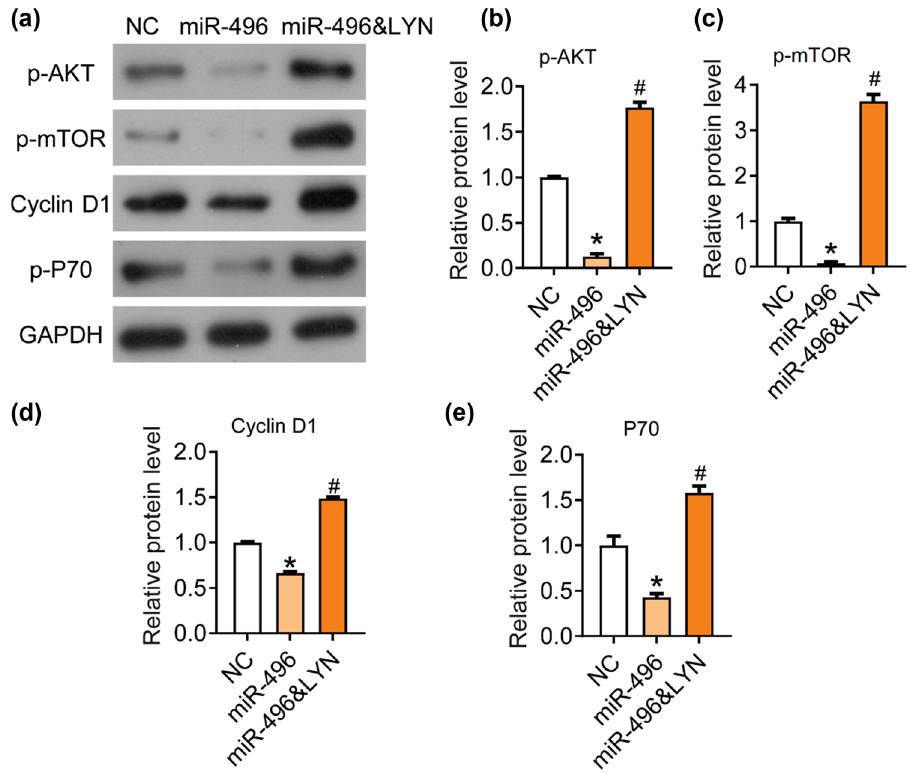
Figure 5: miR - 496 inhibited the AKT/mTOR signaling pathway by targeting LYN in gastric cancer cells. ( a ) The expression levels of AKT/mTOR pathway - related proteins, ( b ) p - AKT, ( c ) p - mTOR, ( d ) Cyclin D1, ( e ) P70 were detected by western blot. The relative protein levels were normalized to NC group. NC = negative control. * P < 0.05; # P <